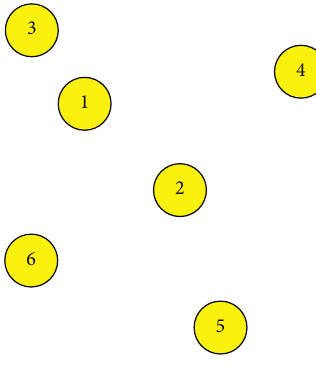
Figure 3: Initial state.